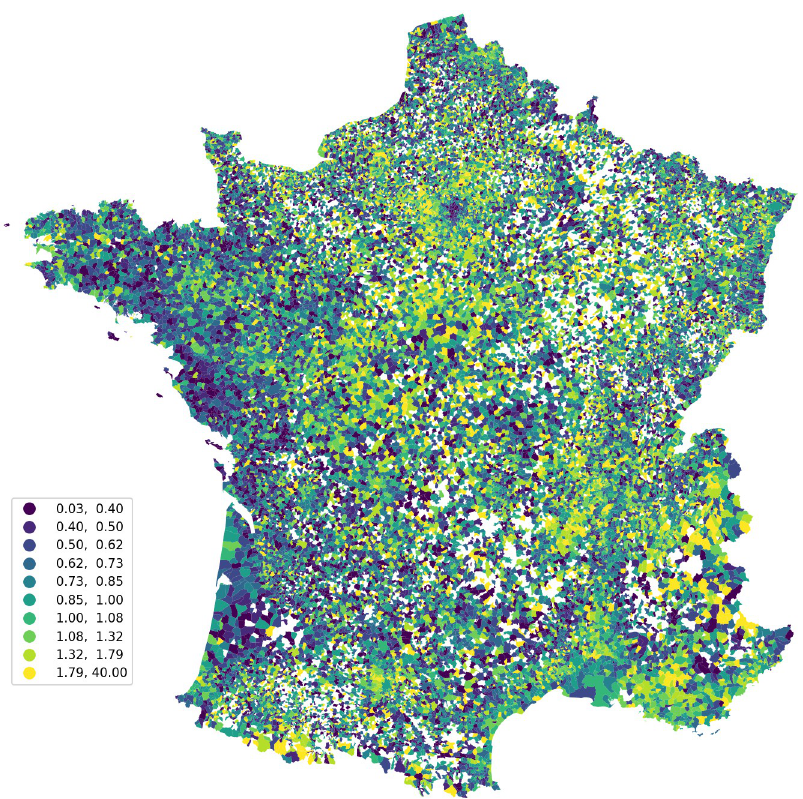
Fig 3. Representativeness of the database through space. Note: Average number of ads per unit in all strata of a municipality. Authors’ computations and Admin Express Commune which is under an Open Licence Etalab https://